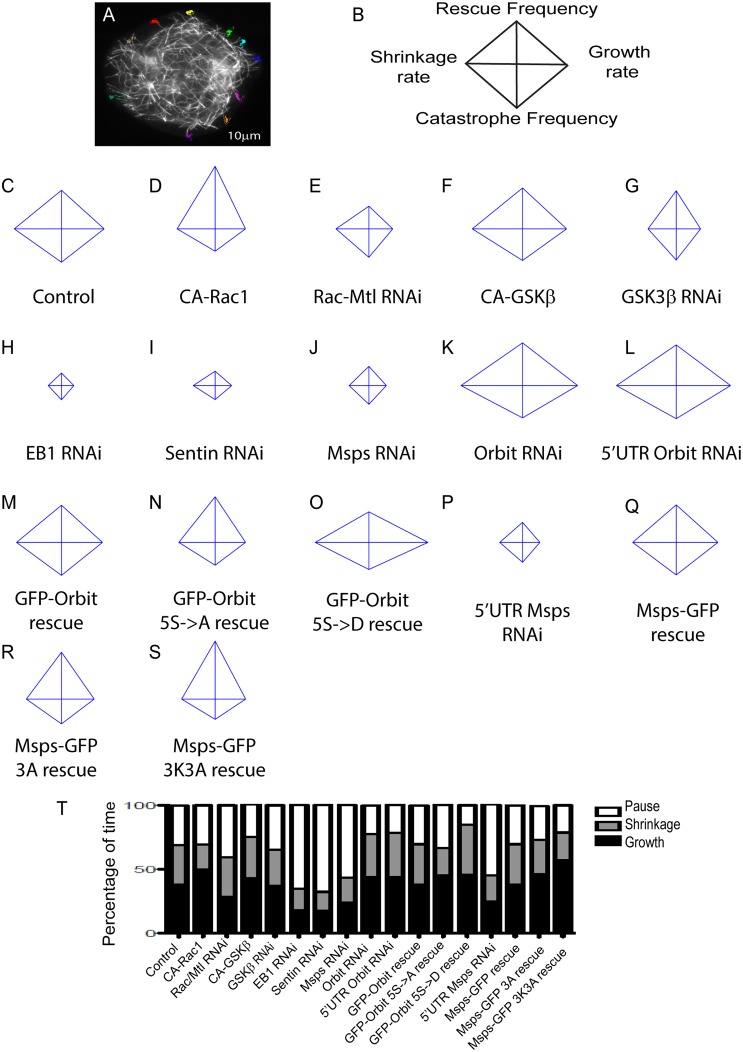
Measurement of microtubule dynamics.(A) Representative image of a cell with microtubules that were tracked. Each number represents a separate track. 10 microtubules per cell were tracked at the periphery of the cell for at least 30 seconds. 30 cells per condition were tracked, the experiment was repeated three times, with 10 cells per replicate. Between 5–10 microtubules were tracked per cell. (B) Representative schematic of a diamond plot with the rates on the x-axis, growth (right) and shrinkage (left) and frequency on the y-axis, rescue (up) and catastrophe (down). (C-R) Diamond graphs of microtubule dynamics under each condition. Diamond graphs are jointly normalized. (S) Graphs showing percentage of time microtubules spent in growth, shrinkage and pause with each condition.